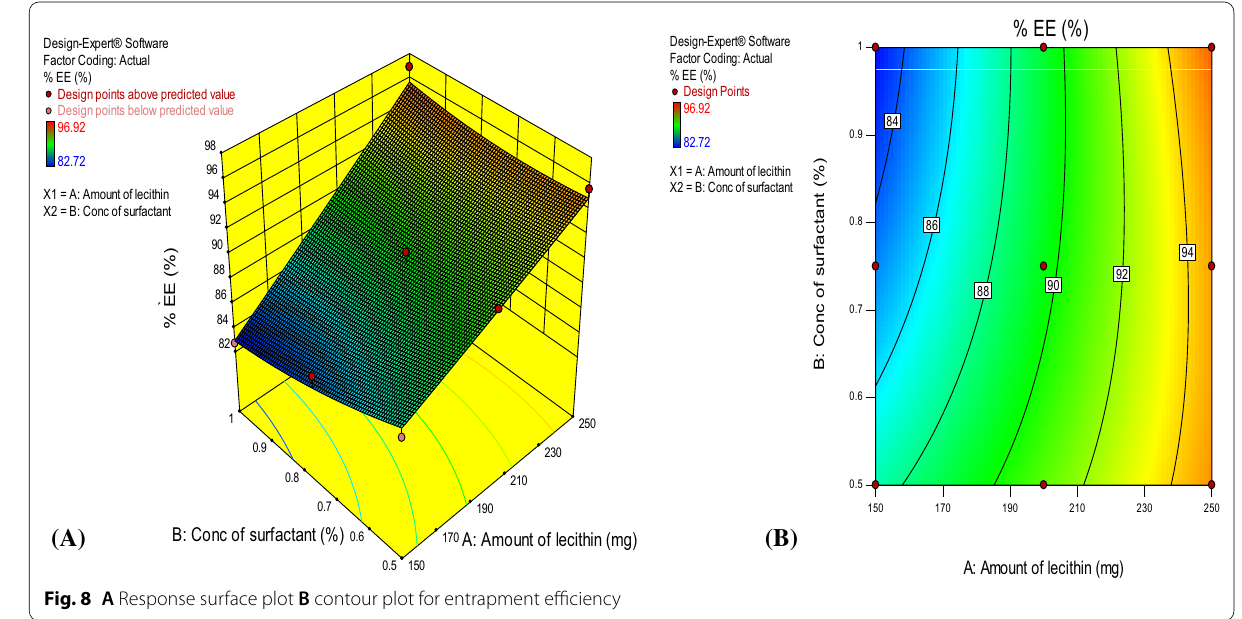
Fig. 8 A Response surface plot B contour plot for entrapment efficiency